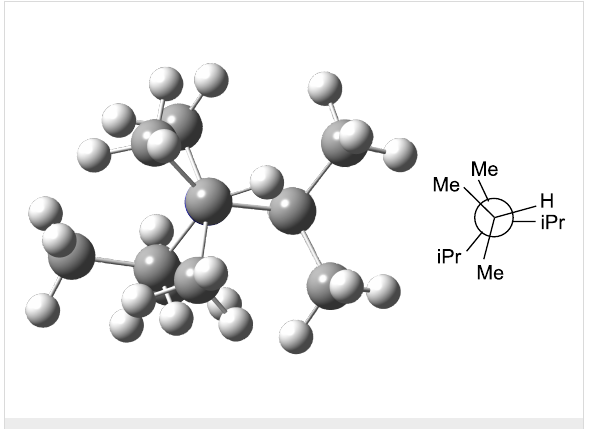
Figure 2: Eclipsing interactions in the best conformation of N + Me(iPr) 3 ( 16Me ) (left), and the corresponding Newman projection through the C–N bond